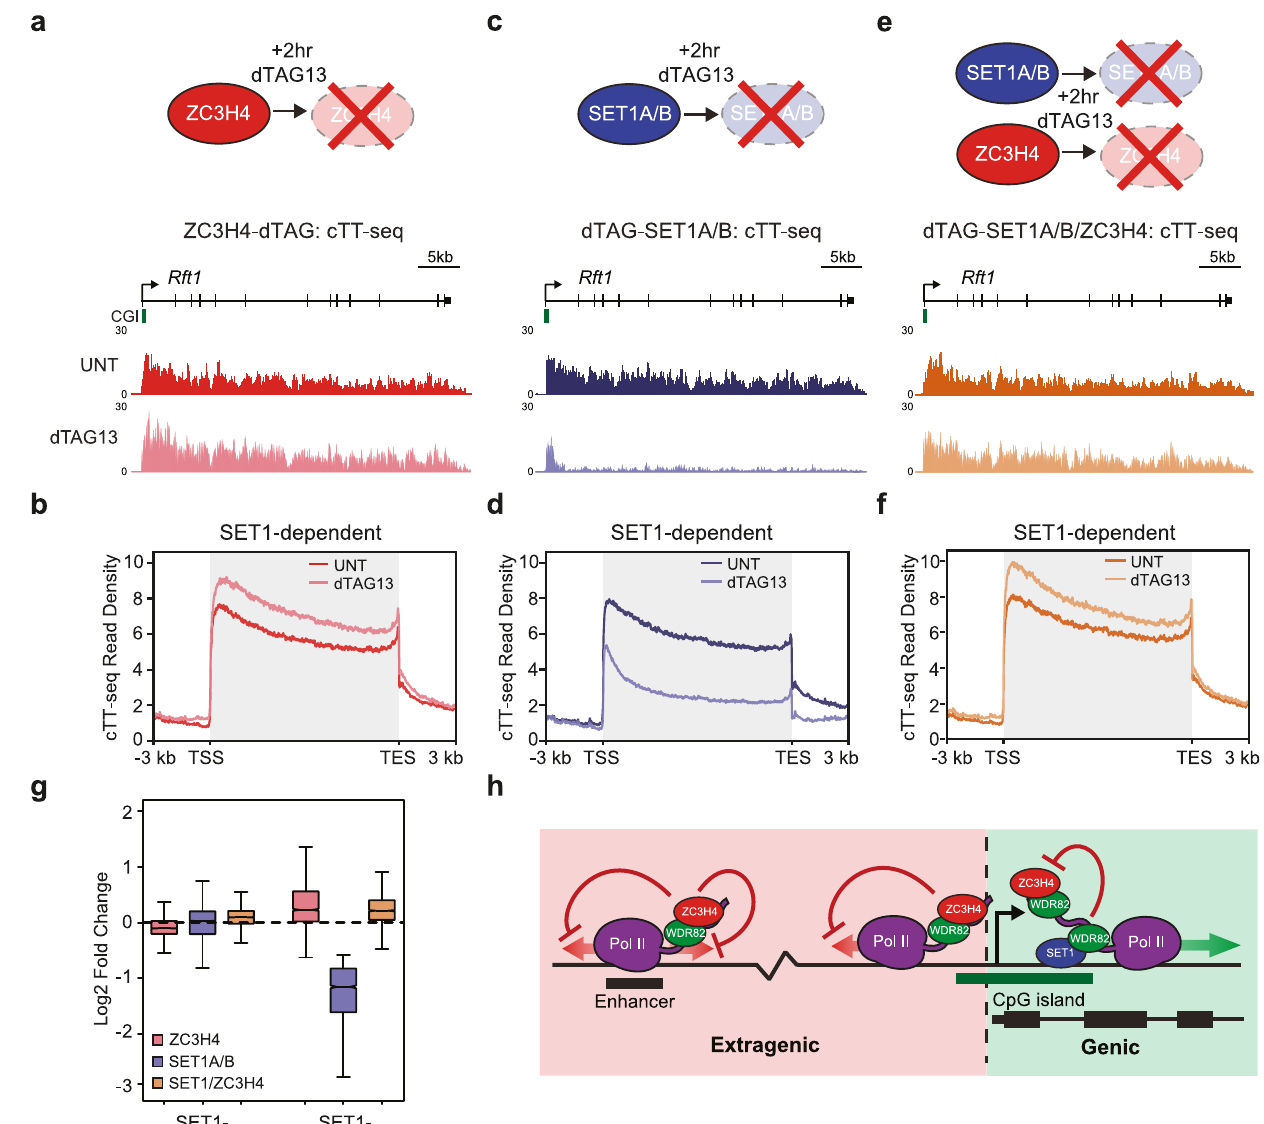
Fig. 6 | SET1 complexes counteract premature transcription termination by ZC3H4. a A schematic illustrating the ZC3H4-dTAG line (top panel) and a genomic snapshot showing cTT-seq signal at a SET1-dependent gene ( Rft1 ) before (UNT, dark red) and after (light red) 2 h treatment with dTAG13 (bottom panels). b Metaplot analysis of transcription (cTT-seq) in the ZC3H4-dTAG line in cells that are either untreated (UNT) or treated with dTAG13 for 2h at all transcribed SET1-dependent genes ( n =2633). c , d As per a and b but for the dTAG-SET1A/B line. e , f As per a and b but for the dTAG-SET1A/B/ZC3H4 line. g A box plot showing the log2 fold change in transcription at transcribed SET1- independent ( n =9151) and SET1-dependent ( n =2633) genes in the dTAG- SET1A/B, ZC3H4-dTAG, and dTAG-SET1A/B/ZC3H4 lines after treatment with dTAG13 for 2h. The boxes show interquartile range, centre line represents median, whiskers extend by 1.5× IQR or the most extreme point (whichever is closer to the median), while notches extend by 1.58× IQR/sqrt(n), giving